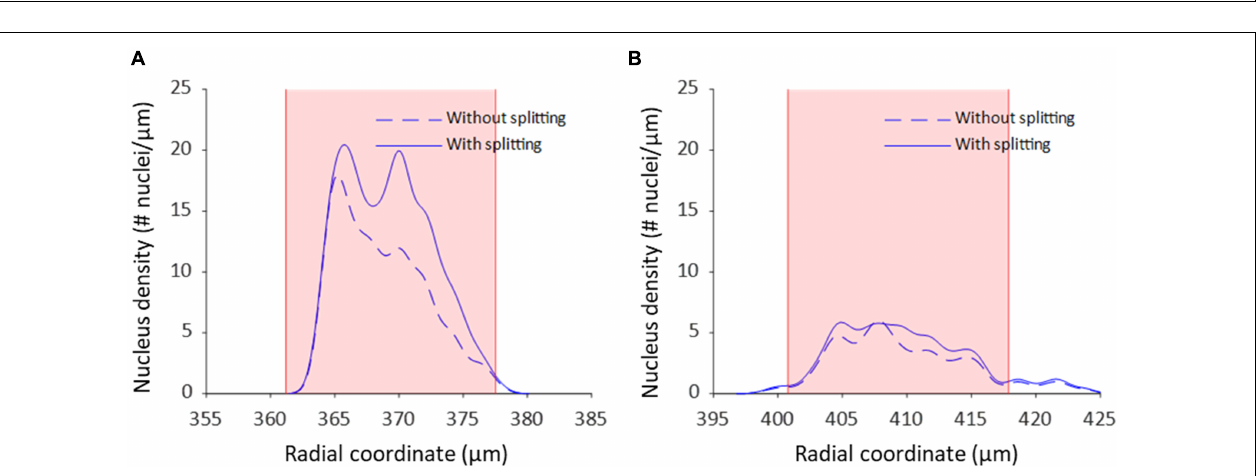
FIGURE 8 | Nuclear splitting improves accuracy of cell content quantification. (A) Shows the differences between the manual and automated counts, normalized with respect to the manual count. The dashed lines depict simple linear regression lines of both counts. * p = 0.008 and p = 0.953 for the slope and intercept, respectively. ** p = 0.653 and p = 0.789 for the slope and intercept, respectively. (B) Automated nucleus counts without and with splitting, against the manual count. The formulas for the dashed lines in panel B are directly derived from the linear regression coefficients of their respective relative data shown in (A) .